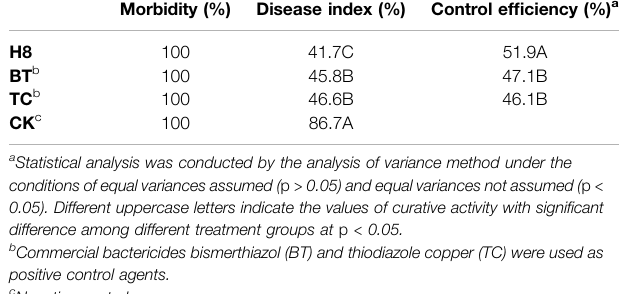
TABLE 3 | The curative activity ofcompoundH8 against Xanthomonas oryzae pv. oryzae in Vivo at 200 μ g/ml. Treatment